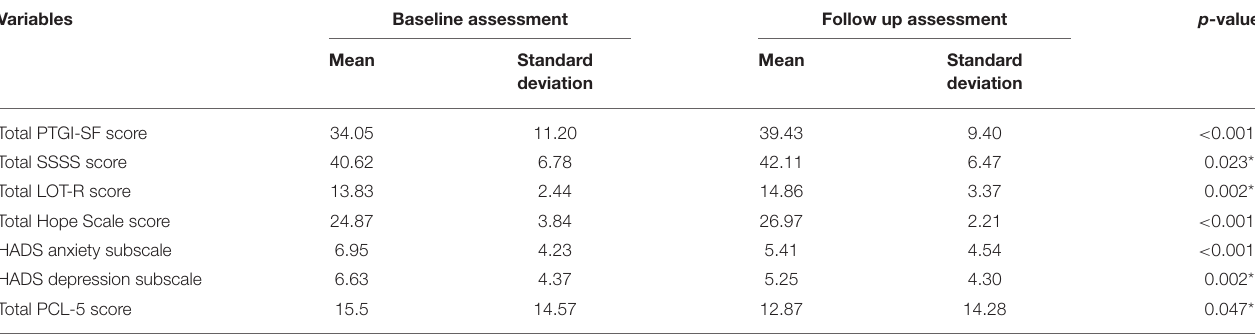
TABLE 2 | Mean total PTGI-SF, SSSS, LOT-R, Dispositional Hope Scale, PCL-5, and HADS subscale scores during baseline and follow up assessments.